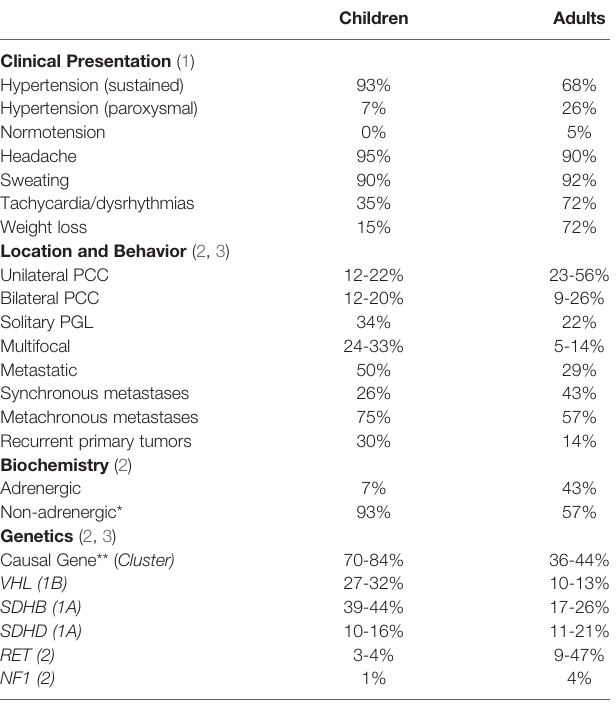
TABLE 1 | Data on pediatric and adult PPGLs from studies directly comparing the two populations.